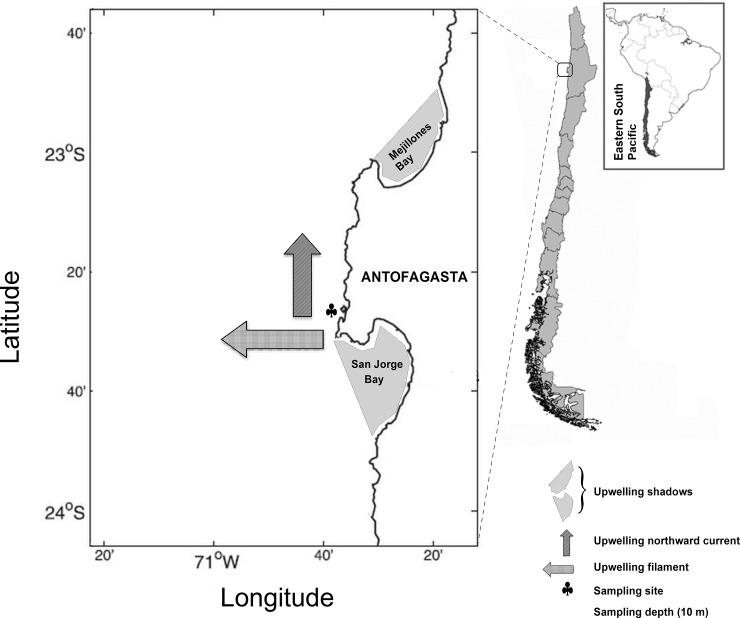
Map of the study area.Monitoring was carried out during 2015 in a coastal site exposed directly to upwelling filaments. The former generates nearshore northward currents, which later enter into northern Mejillones Bay as upwelling shadows.